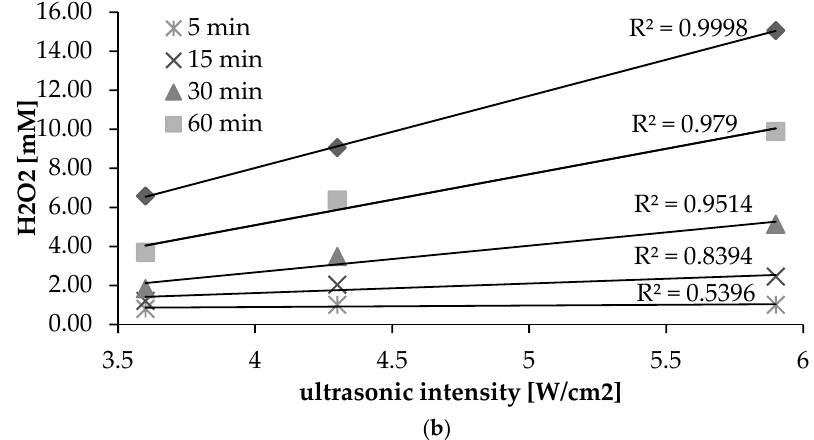
Figure 2. ( a ) Influence of duration and intensity of ultrasonic irradiation (pH = 7) on the formation of H 2 O 2 ; ( b ) relationships between ultrasonic intensity and formation of H 2 O 2 .